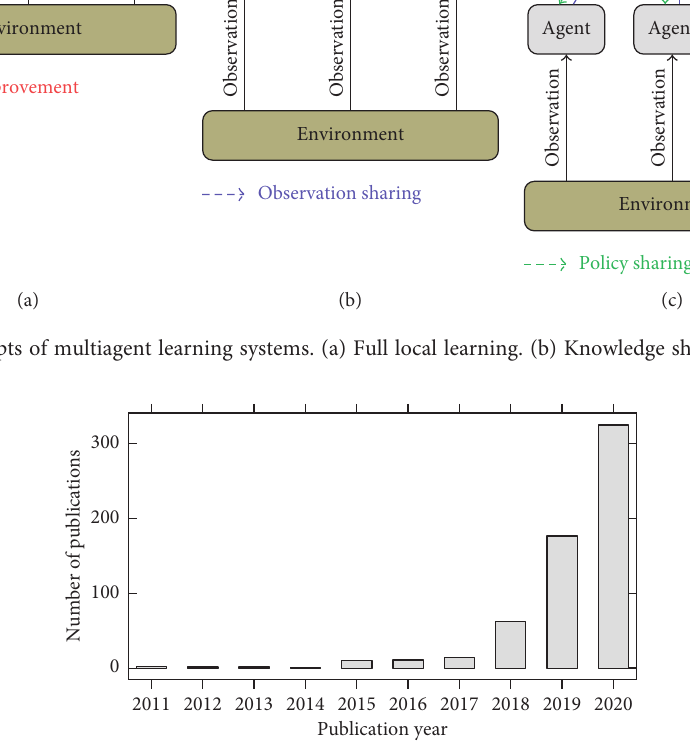
Figure 7: Distribution of publications processed in our analysis by publication